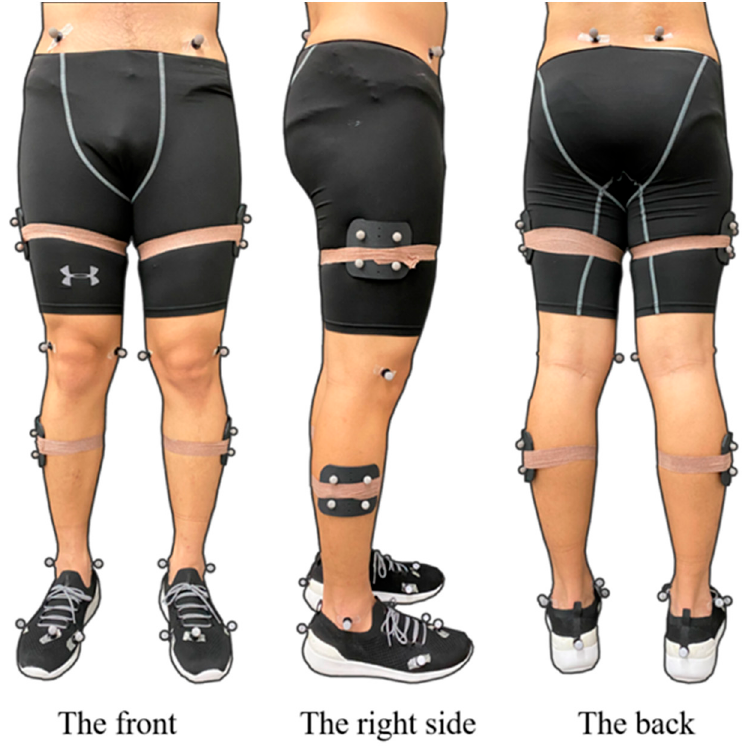
Figure 2. Illustration of marker placements on three sides.